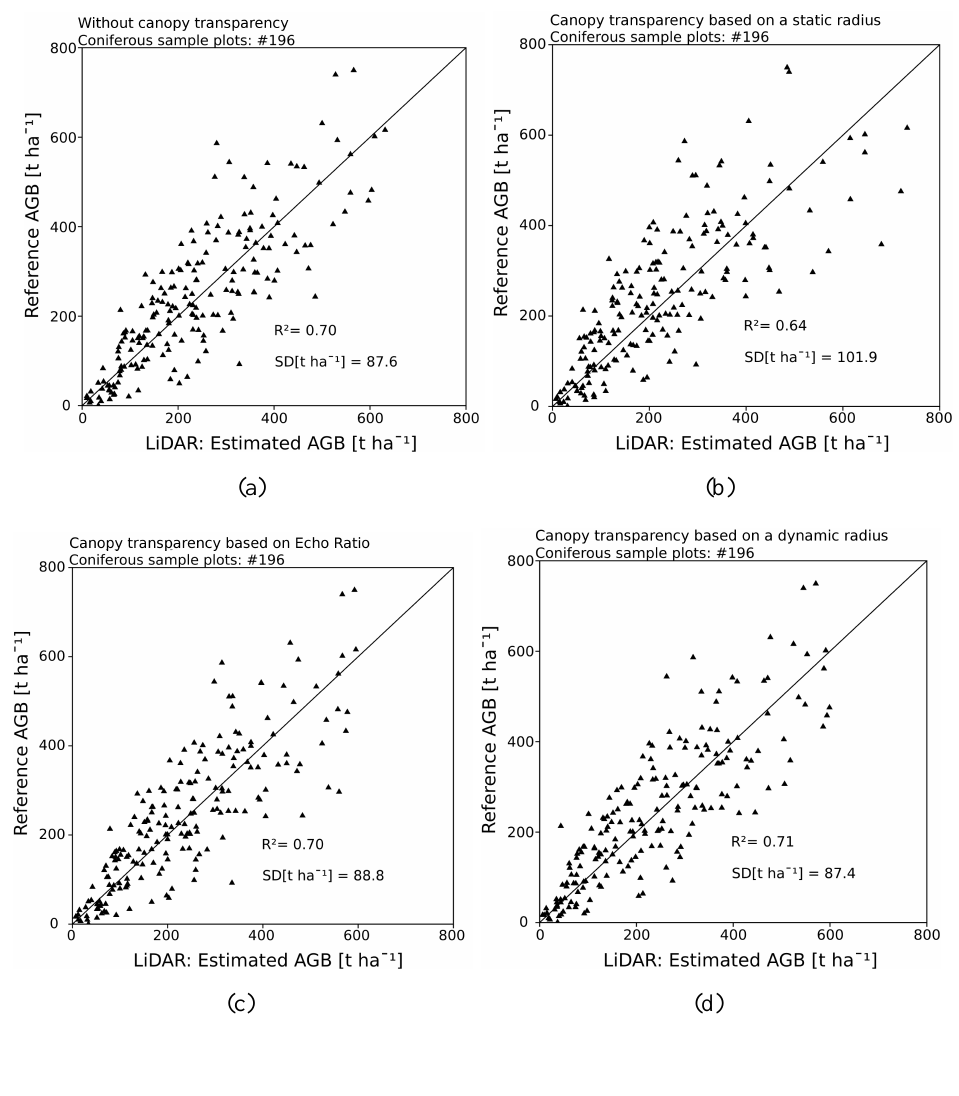
Figure 3. Scatter plots showing the aboveground biomass derived from the local forest inventory versus the aboveground biomass estimated from 3D LiDAR first echo point cloud